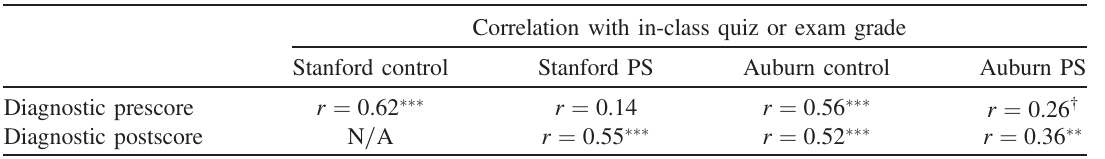
TABLE V. Pearson correlation r between quiz grade and various measures of incoming preparation and postcourse scores on the diagnostic. † p < 0 . 10 , (cid:2) p < 0 . 05 , (cid:2) (cid:2) p < 0 . 01 , (cid:2) (cid:2) (cid:2) p < 0 . 001